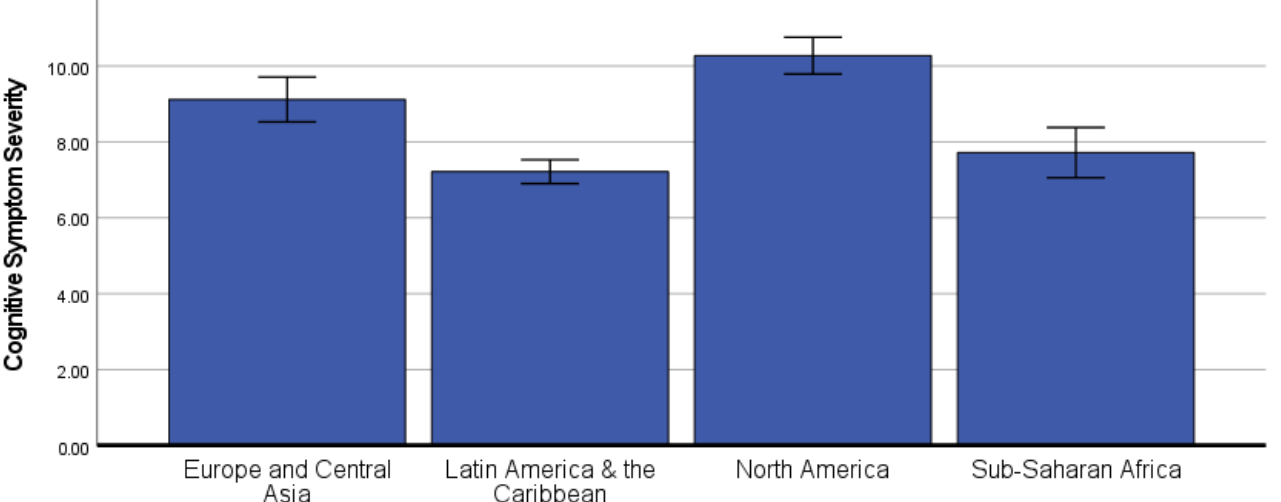
Figure 2. Covariate-adjusted cognitive symptom severity scores (mean with 95% confidence interval) by global region. Note : A graphic that shows the differences in cognitive symptoms by Global Region. The participants from North America reported the greatest cognitive symptoms. Additionally, participants from Europe and Central Asia reported significantly greater cognitive symptom severity than participants from Latin America and the Caribbean and Sub-Saharan Africa.